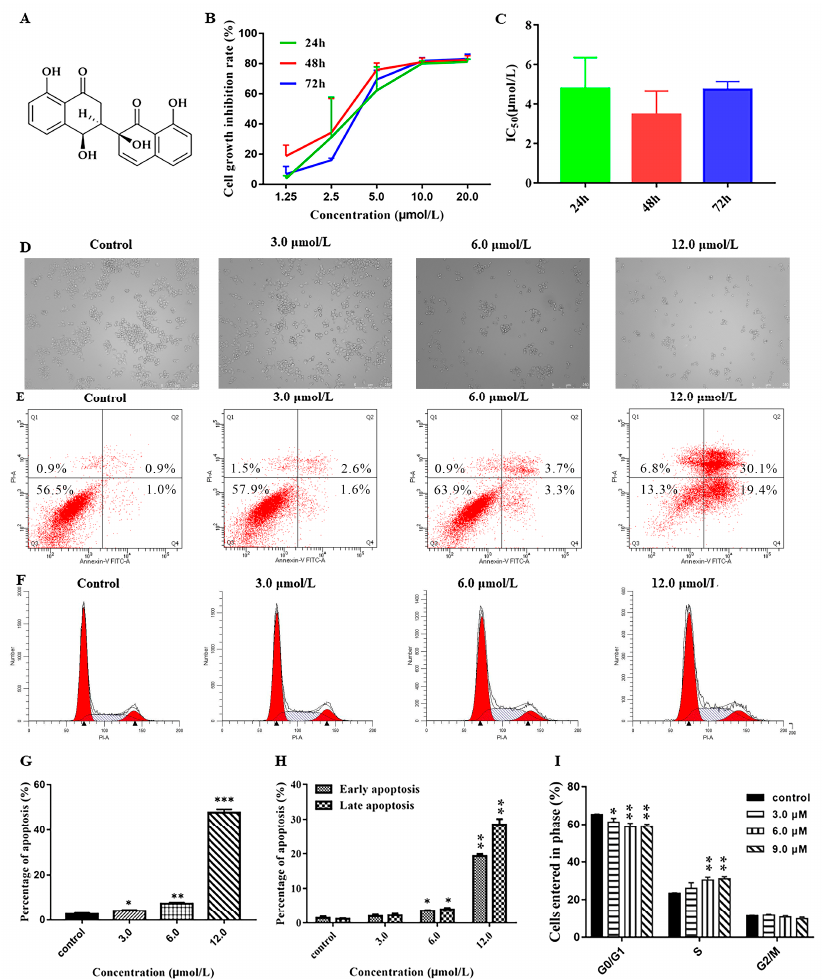
Figure 9. The effect of Neogrisphenol A on A2780 cell growth at various doses. ( A ) The chemical structure of NeoA; ( B ) The MTT test was used to detect the inhibitory impact of NeoA on the proliferation of A2780 cells; ( C ) The semi-inhibitory concentration (IC 50 ) values of NeoA at various periods (24, 48, and 72 h); ( D ) Using an inverted microscope (magnification = 100 × ), morphological alterations in A2780 cells treated with various doses of NeoA for 24 h were detected; ( E ) Flow cytometry was used to assess the apoptosis of A2780 cells; ( F ) Flow cytometry was used to detect cell cycle alterations in the A2780 cell line in the control (DMSO) and NeoA groups at various doses; ( G ) The total rate of apoptosis in A2780 cells that were treated with various concentrations of NeoA; ( H ) A comparison of the effects of various concentrations of NeoA on the early and late apoptosis rates in A2780 cells; ( I ) The proportion of A2780 cells in each of the three cell-cycle stages altered following treatment with NeoA. The data is presented as the mean ± SD (n = 3). * p < 0.05, ** p < 0.01, *** p < 0.001 vs. the control (DMSO) group; n.s, non-significant. For statistical analysis, one-way ANOVA and multiple t tests were both